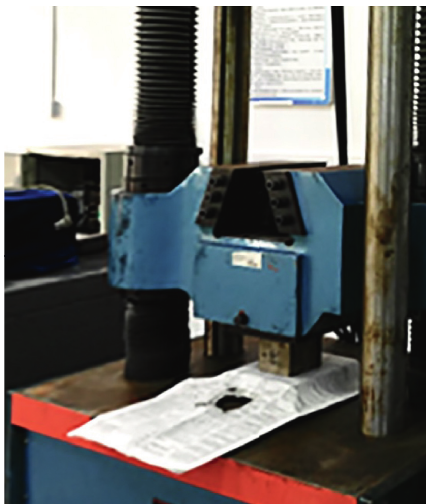
Figure 2: Compressive strength test of cement concrete used in this paper.